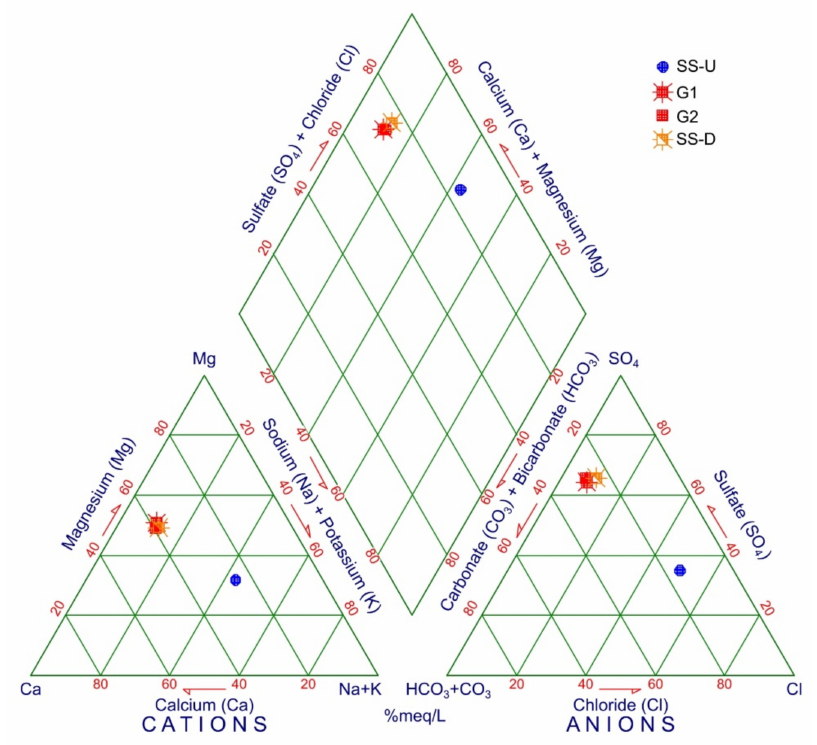
Figure 4. Piper diagram of the studied waters (average values from April 2017 to December 2019, n =